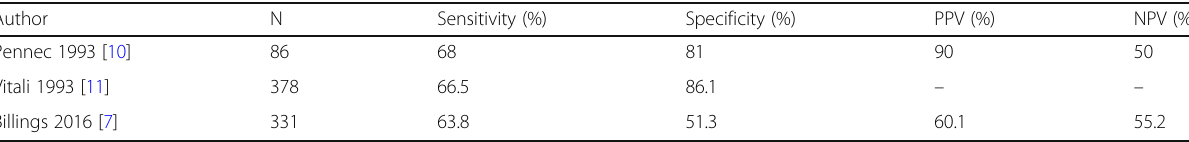
Table 1 Sialometry for the diagnosis of Sjögren ’ s syndrome Author